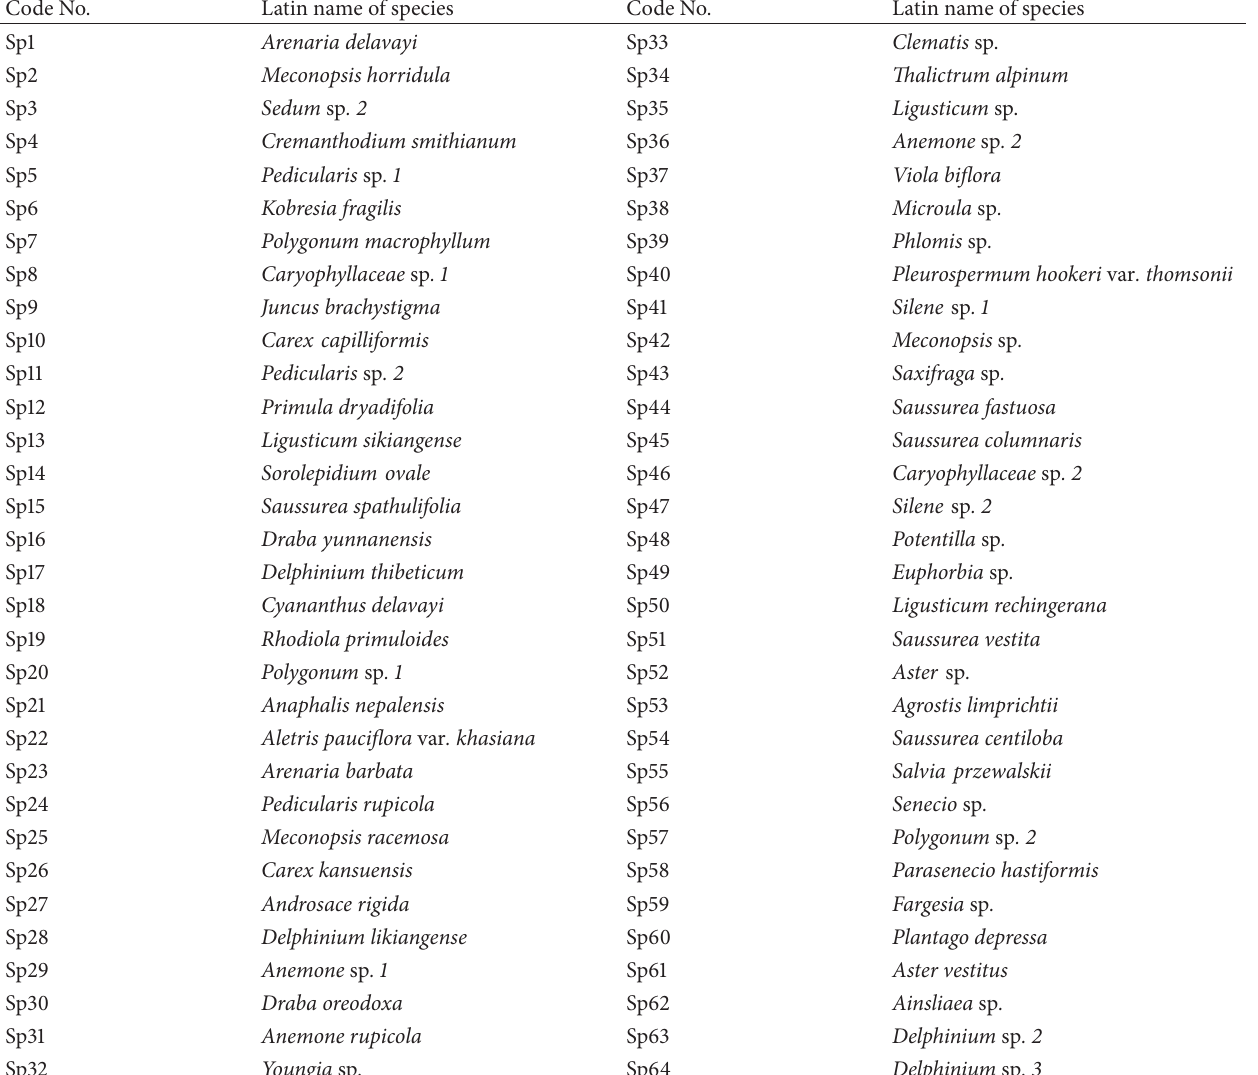
Table 2: Latin name of herbaceous plants in the foreland of Glacier-BS1 on Mt. Yulong. Code